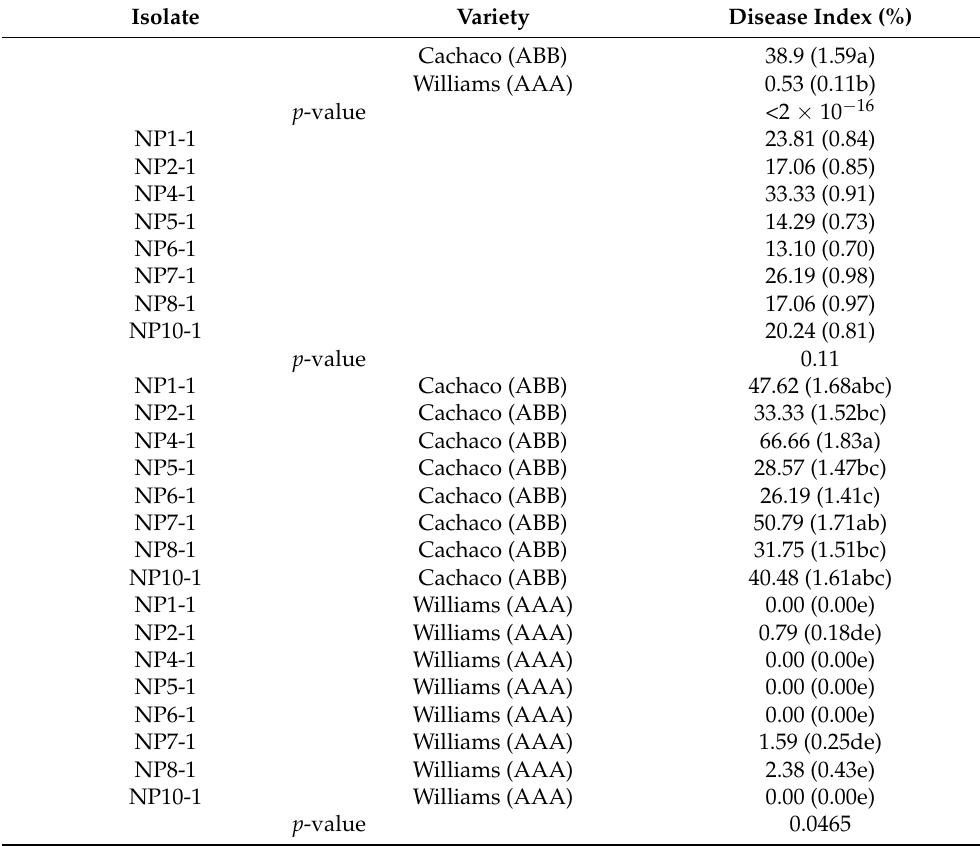
Table 3. The disease index of isolates on the